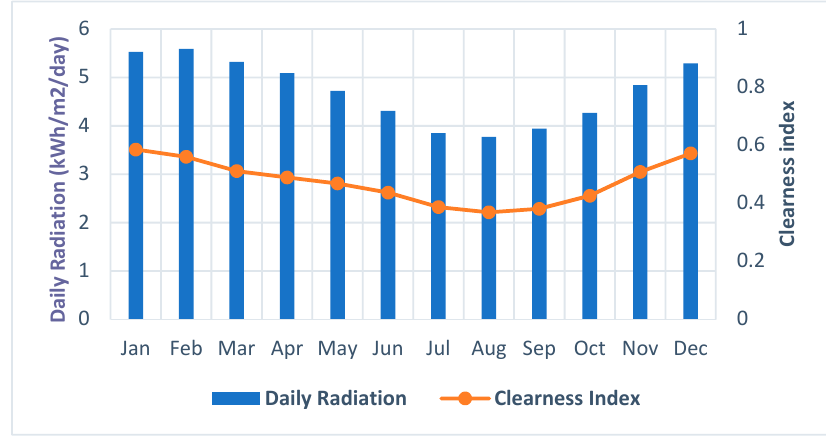
Figure 4. Monthly average solar irradiation for the village of Mboke. Electronics 2020 , 9 , x FOR PEER REVIEW